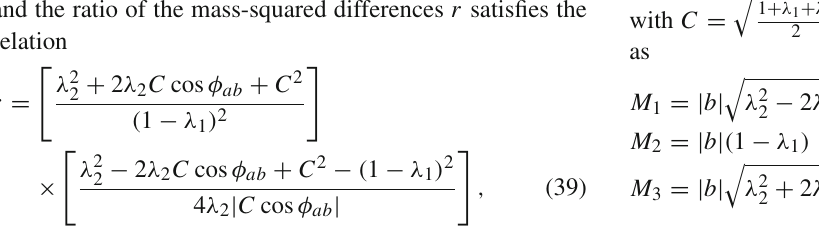
Fig. 2 Variation of λ 2 , m l and (cid:4) φ i m i with ab , red points are for the inverted hierarchy and green points are for the normal hierarchy